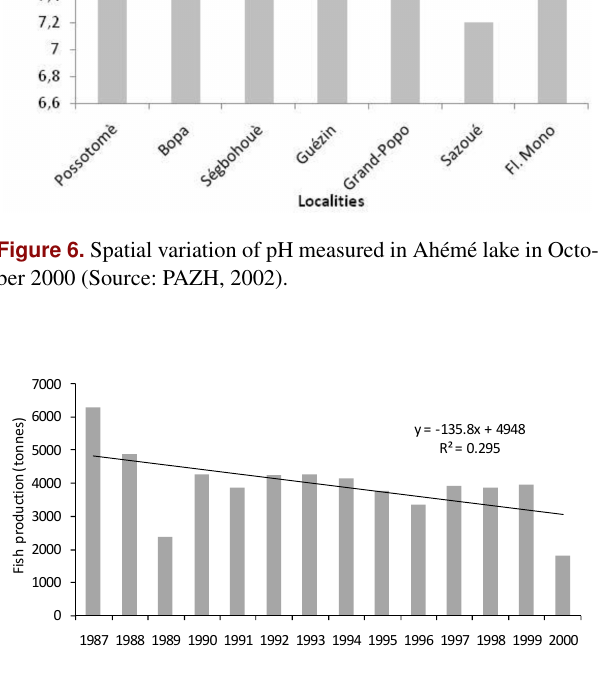
Figure 7. Annual fish production in Ahémé lake from 1987 to 2000 (Source: Fish farming Directorate,